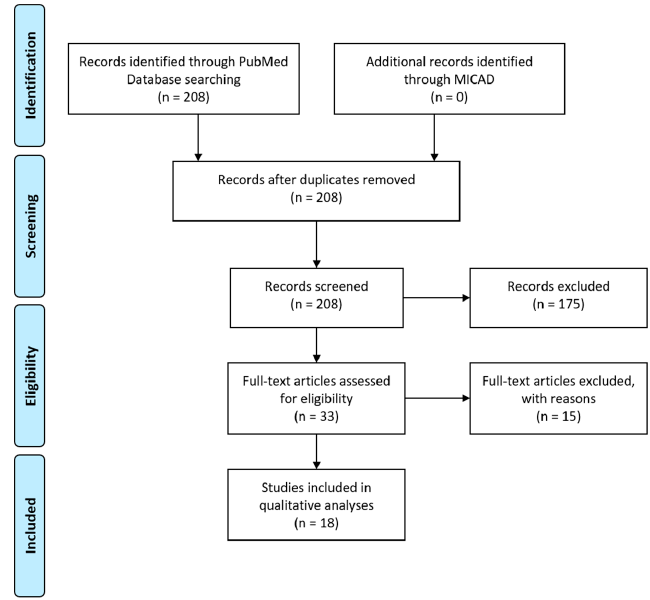
Figure 4. Literature search for B1R and B2R imaging agents. Flow diagram to illustrate the process